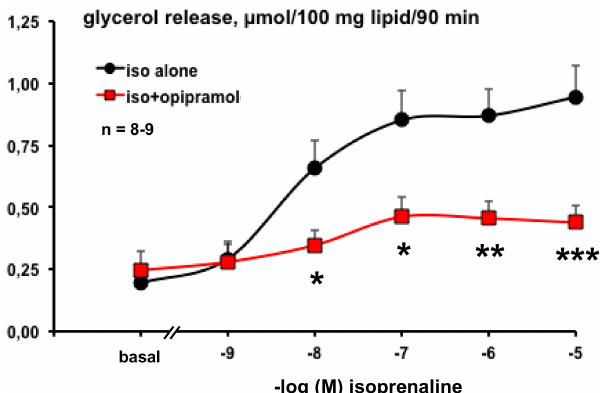
Figure 2. Impairment by opipramol of isoprenaline lipolytic activation in human subcutaneous adipocytes. Isoprenaline was tested alone at increasing concentrations (iso alone, black circles, control) or in the presence of 100 µ M opipramol (red squares). Spontaneous glycerol release from freshly isolated adipocytes (basal) was also tested without and with opipramol. Each point is the mean ± SEM of 8–9 determinations. Di ff erent from the corresponding control at *: p < 0.05; **: p < 0.01; ***: p <